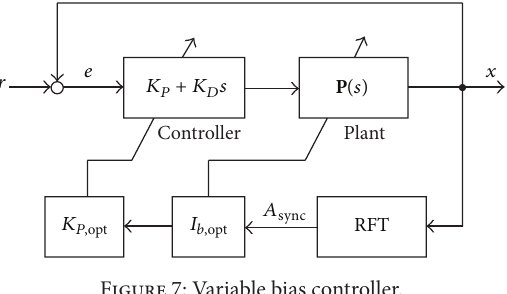
Figure 7: Variable bias controller.